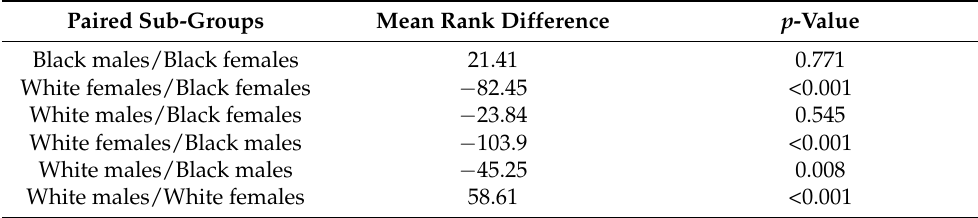
Table 6. Results of Dunn’s test comparing AMTL frequency between pairs of